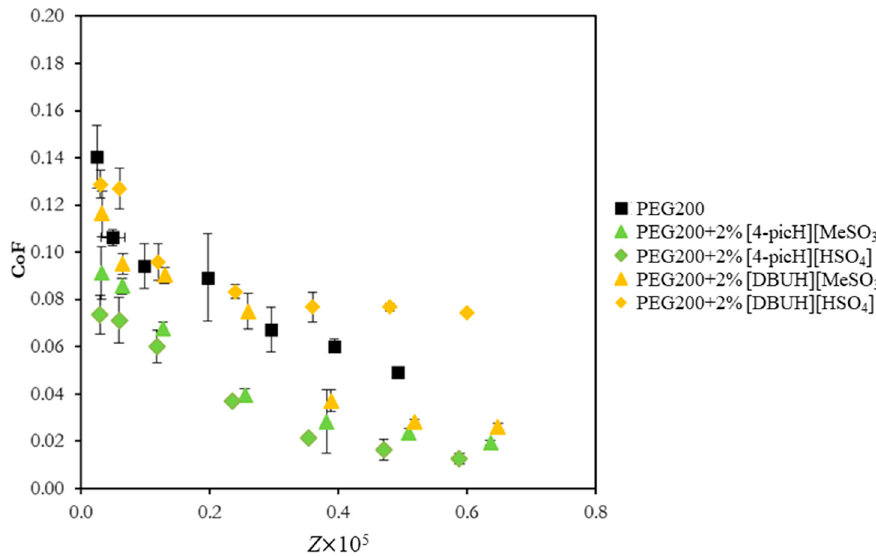
Figure 3. CoF vs. Sommerfeld parameter, Z , for the pair Si sphere/Si substrate using neat PEG200 and the mixtures PEG200 + 2% PIL as lubricants in short tests under load of 1 N. The errors are ± standard deviation (n ≥